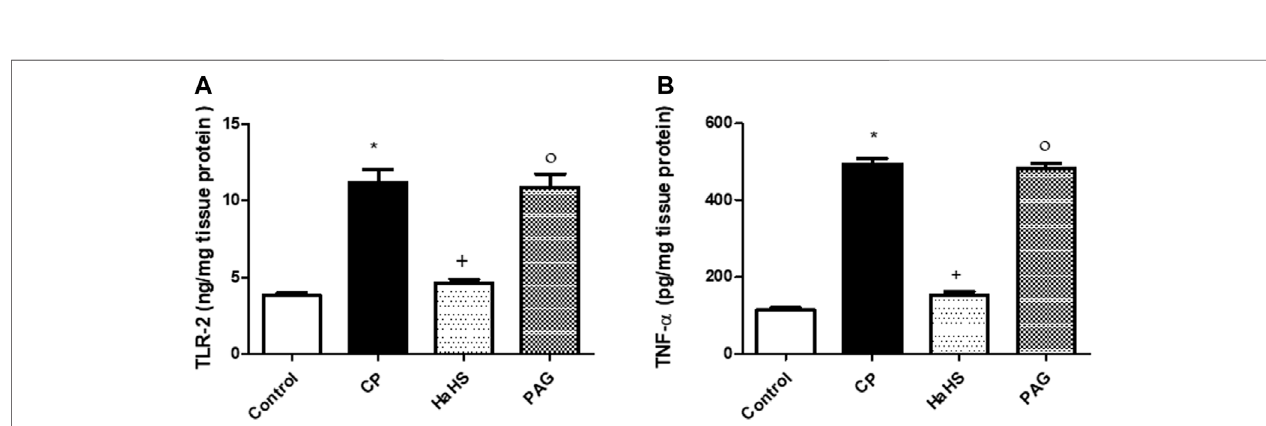
FIGURE 5 | The effect of NaHS and PAG on hepatic level of TLR-2 (A) and TNF- α (B) in CP-induced hepatotoxicity in rats. Data are represented as mean ± SEM. *,+, ° aresigni fi cantlydifferentfrom control, CPand NaHS groups, respectively,where n=6and p < 0.05.CP; cyclophosphamide, PAG;DL-propargylglycine, TLR2; Toll- like receptor 2, TNF- α ; tumor necrosis